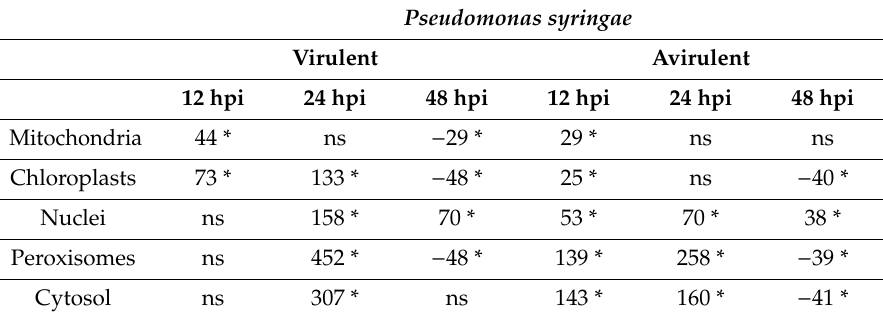
Table 2. Changes in percentage of subcellular glutathione contents in Arabidopsis infected with Pseudomonas syringae . Glutathione contents were determined at di ff erent hours post inoculation (hpi) in plants infected with a virulent and avirulent strain of Pseudomonas syringae pv. tomato DC3000 and compared to the control [75]. Significant di ff erences were calculated with the Kruskal-Wallis test followed by post-hoc comparison according to Conover at p < 0.05. * indicates significance at the 0.05 level of confidence; ns = not significantly di ff